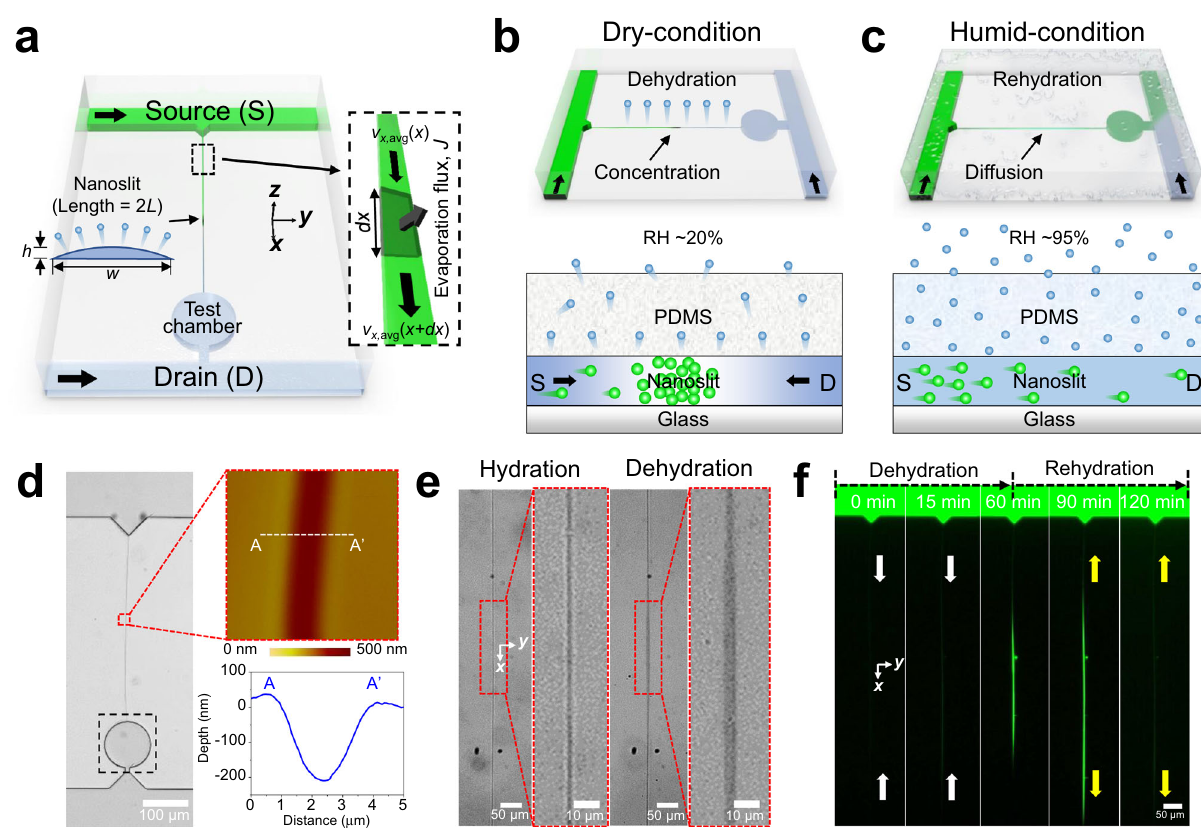
Fig. 1 Global, evaporation-controlled, micro/nano fl uidic device (GECMN) for transport control of small molecules. a Schematic illustration of the GECMN consisting of two microchannels connected to the nanoslit. b Diffusive mass transport of small molecules toward the drain channel is prohibited by the evaporation-driven advective fl ow from the drain toward the center of the nanoslit, making the small molecules accumulate in the dehydrated nanoslit. c Accumulated small molecules transport toward the drain channel due to diffusion for the hydrated nanoslit. d Microscopic and atomic force microscopy (AFM) images depicting the nanoslit morphology. e Microscopic images of the nanoslit at high and low humidity, respectively. f Sequential fl uorescence images indicating that the fl uorescein isothiocyanate (FITC) molecules accumulated at low humidity (relative humidity; RH ~20%) and are transported via diffusion at high humidity (RH ~95%) at 1-h